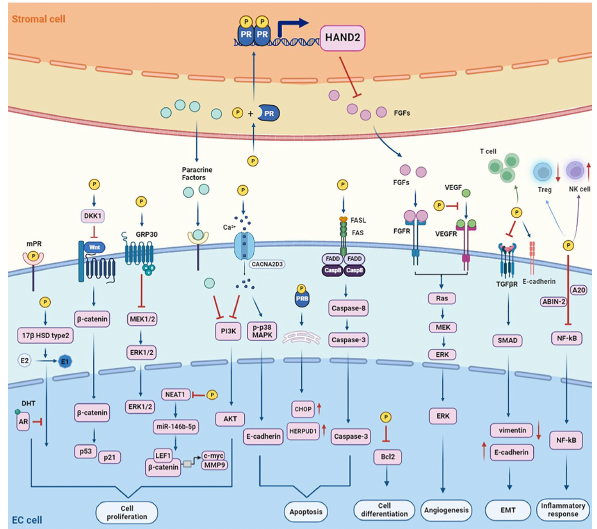
Figure 1. Therapeutic mechanisms of progestin in the endometrium. Progestin regulates the down- stream target genes mainly by binding with PR. Progestin can also work through ER and AR. Pro- gestin affects the cell cycle, angiogenesis, apoptosis, cell differentiation, inflammatory response, and EMT, which are all major therapeutic effects on EH and EC. Additionally, progestin can bind to PR in stromal cells to facilitate paracrine communication between stromal cells and epithelial cells. 2.1. Cell Cycle Arrest It has been reported that progestin elicits G0/G1 cell cycle block in EC cells by regu- lating the lncRNA NEAT1/miR-146b-5p signal pathway [9]. The potential of progestin to suppress the expression of LEF1 and downstream genes c-myc and MMP9 in the Wnt/ β - catenin signal pathway is another explanation for its inhibitory influence on G0/G1 cell cycle progression [10]. Additionally, the G2/M cell cycle block has been seen in EC cells when progestin and alsterpaullone are combined [11]. Another mechanism by which pro- gestin inhibits the cell cycle is via binding to the G protein-coupled receptor 30 (GPR30), which directly stimulates the PI3K/AKT signaling pathway to perform non-transcrip- tional functions [12]. This is a non-classical pathway that rapidly activates the progestin- mediated pathway. Thus, progestin could modestly control the proliferative balance through the PI3K/AKT pathway [13]. 2.2. Anti-Angiogenesis It is well known that progestin exerts antiangiogenic effects in EC. Vascular endothe- lial growth factor (VEGF) is a glycoprotein that induces the proliferation, differentiation, and migration of vascular endothelial cells [14]. It was found that progesterone, MPA, and 17 α -hydroxyprogesterone effectively inhibited the estrogen-induced production of VEGF in Ishikawa cells [15]. The Basic Fibroblast Growth Factor (bFGF) is another potent angi- ogenic factor. Synthetic progestins can inhibit the transcription of bFGF in the endometrial